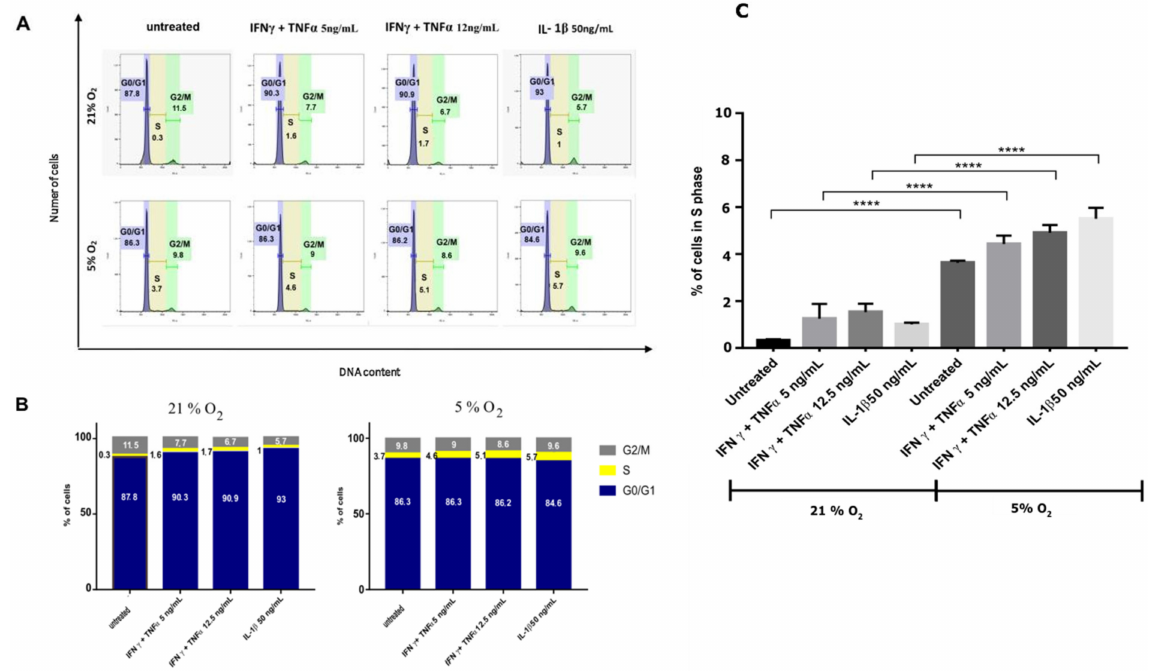
Figure 5. Cell-cycle analysis. ( A )—Histograms were used to analyze the cell cycle in WJ-MSCs after treatment with proinflammatory cytokines under 21% or 5% O 2 concentrations. ( B )—Chart shows the percentage of cells in individual phases of the cell cycle at all tested groups. The results are mean values from 3 independent experiments in min. 3 replicates. ( C )—chart shows the percentage of cells in S -phase of the cell cycle at all tested groups. The results are mean values (one-way ANOVA) from 3 independent experiments in min. 3 replicates ± SD **** p <